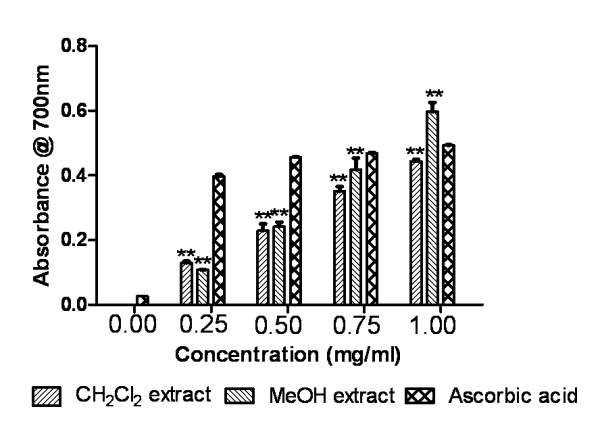
Reducing power assay. Reducing power activities of Dragon's blood resin extracts and standard ascorbic acid. The absorbance (A700) was plotted against concentration of sample. **P < 0.0001 vs 0 μg/ml.